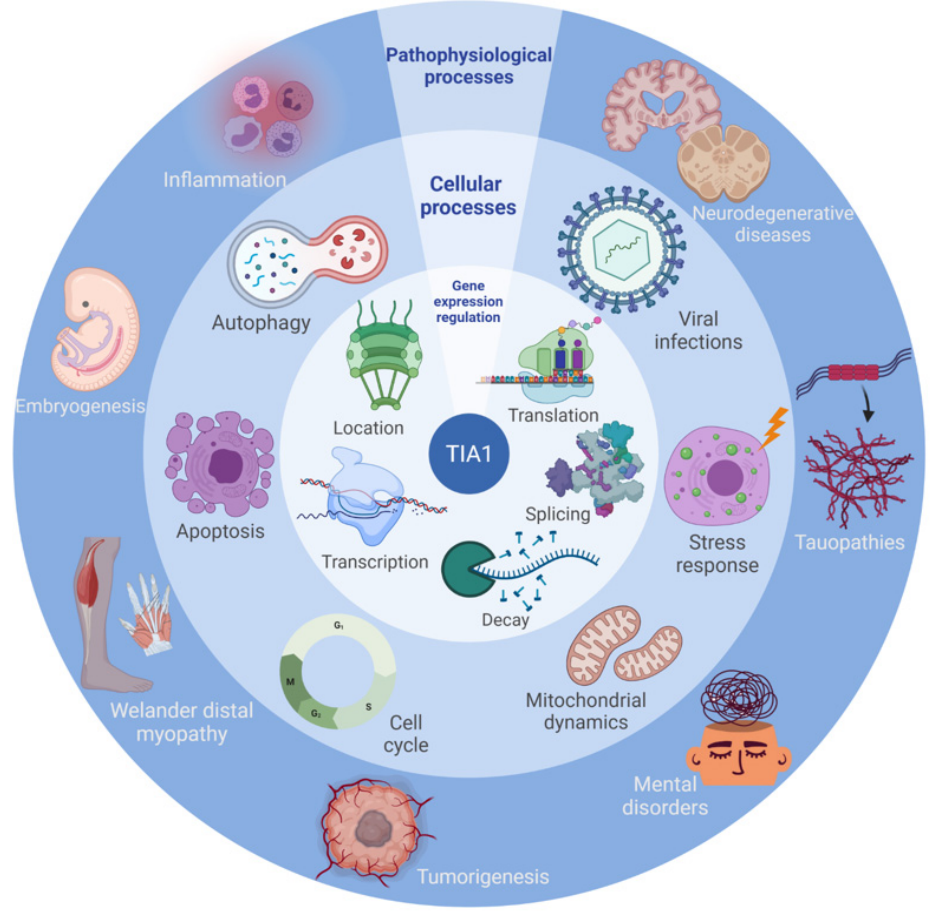
Figure 5. The hallmarks of TIA1 on gene-expression regulation/flux, as well as cellular and patho- physiological processes. Schematic representation of the main processes of gene-expression regulation, cellular events and pathophysiological processes associated with TIA1 expression. This figure was created with BioRender.com (accessed on 20 December